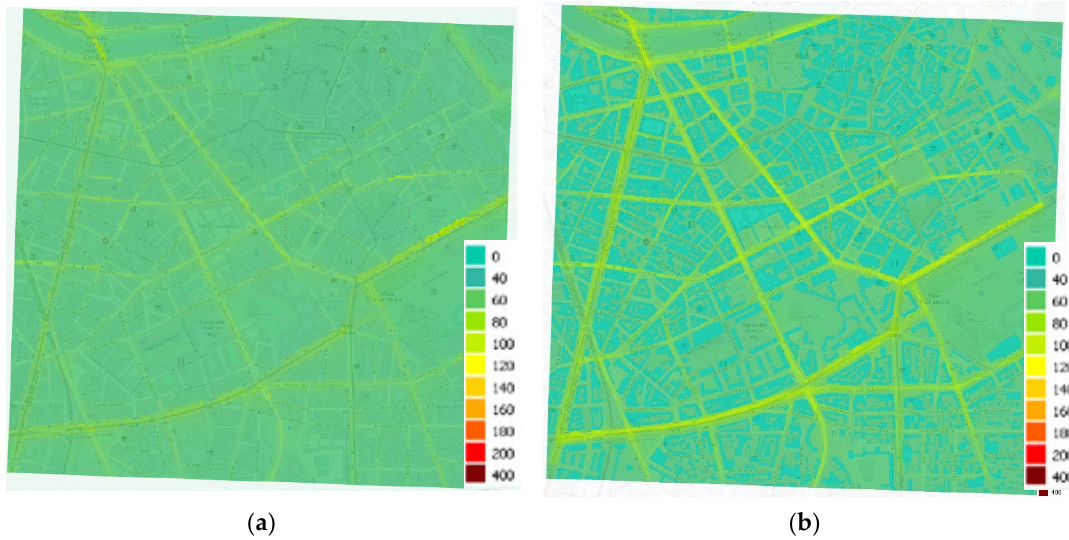
Figure 6. Average NO 2 concentrations maps during the period from the 15th of January 2017 to the 31st of January 2017 computed with SIRANE ( a ) and PMSS ( b ) models.